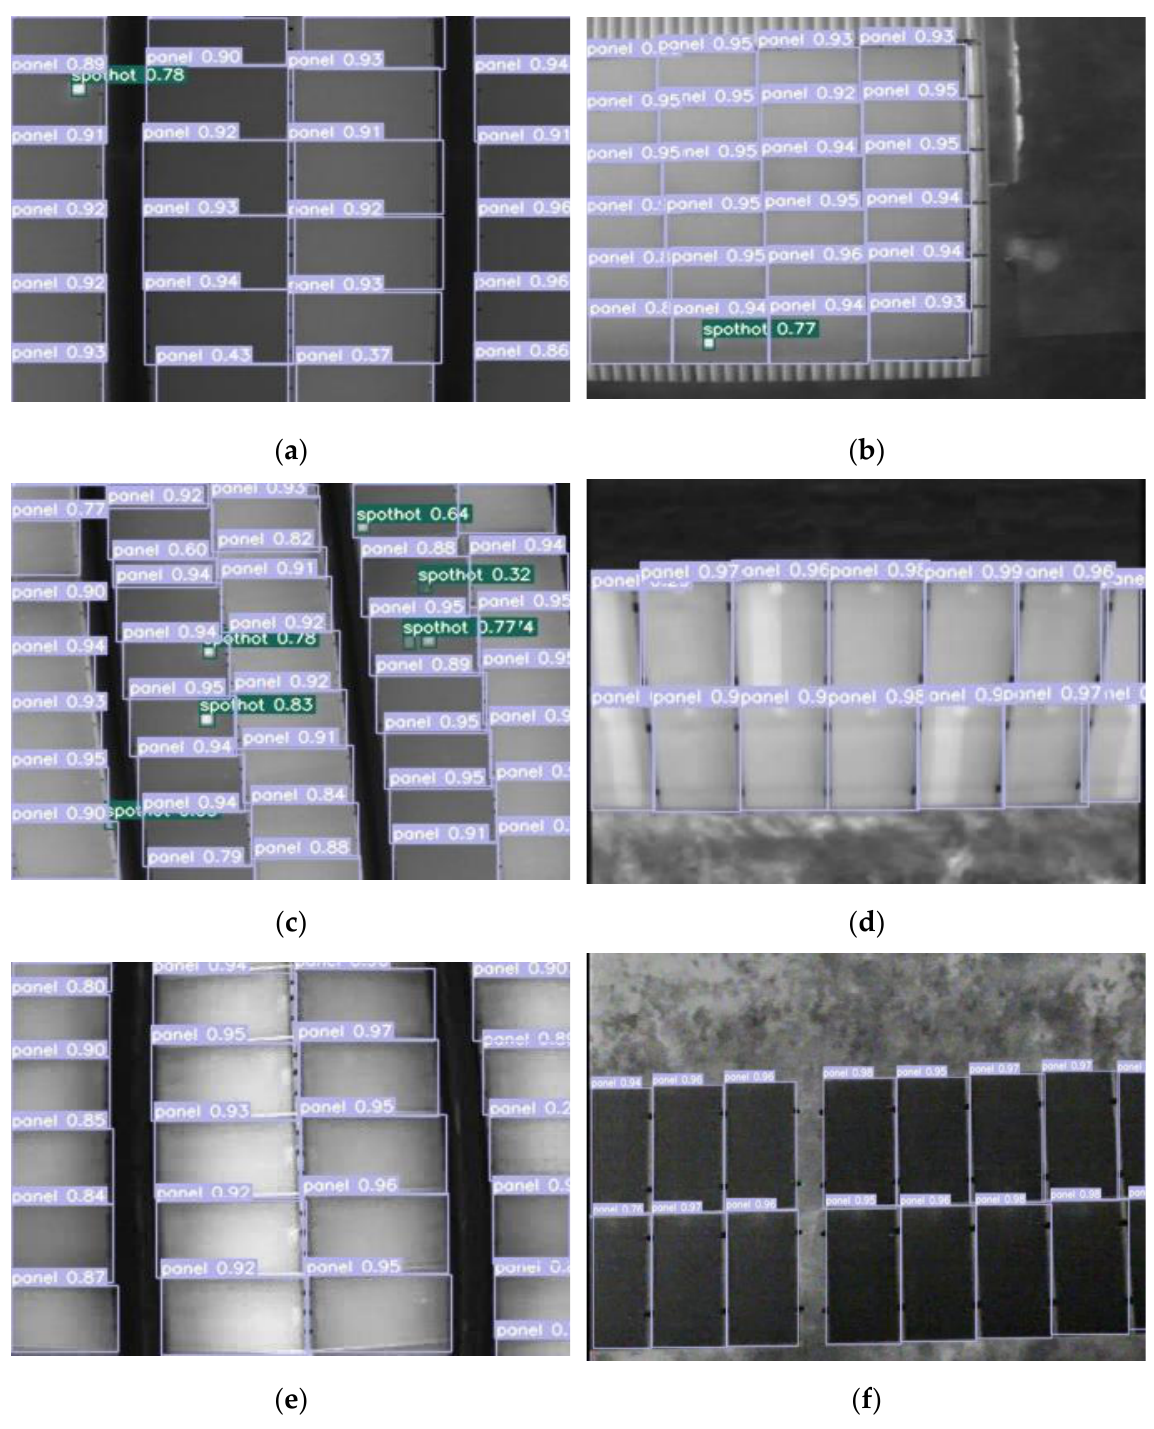
Figure 8. ( a – f ) are partial visualization results.